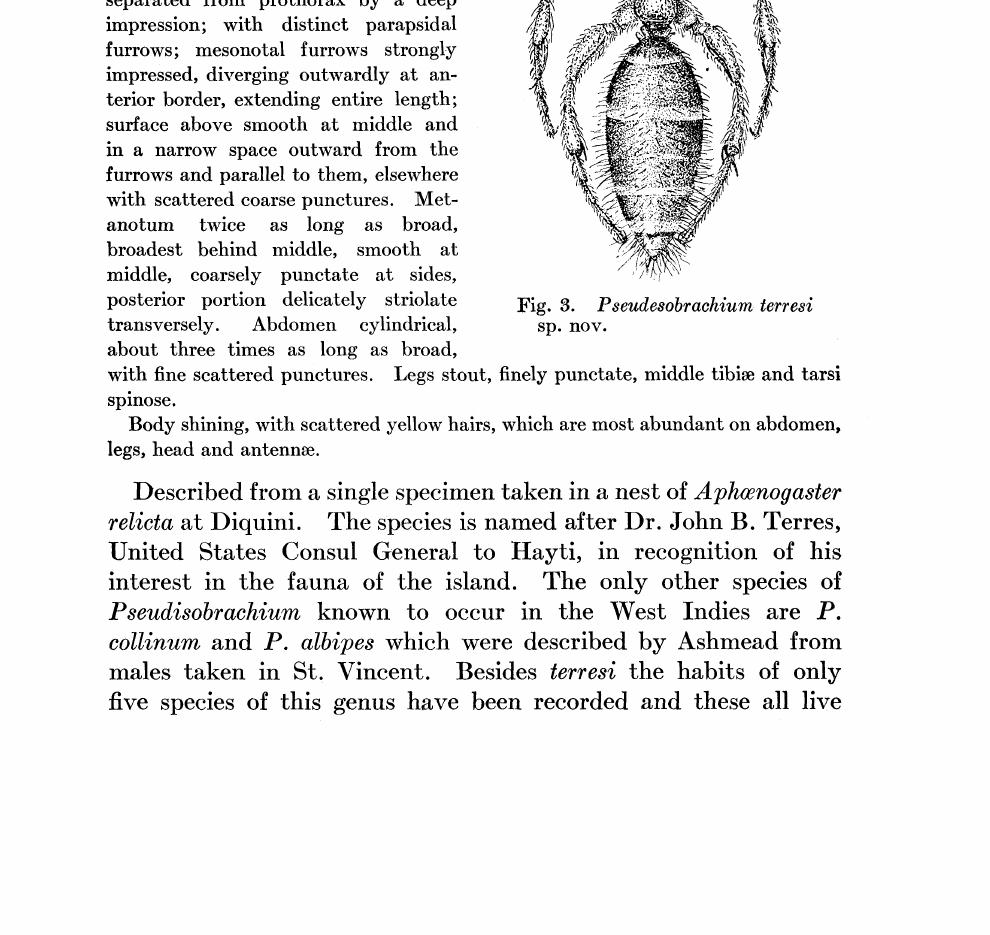
Fig. 3. Pseudesobrachium terresi